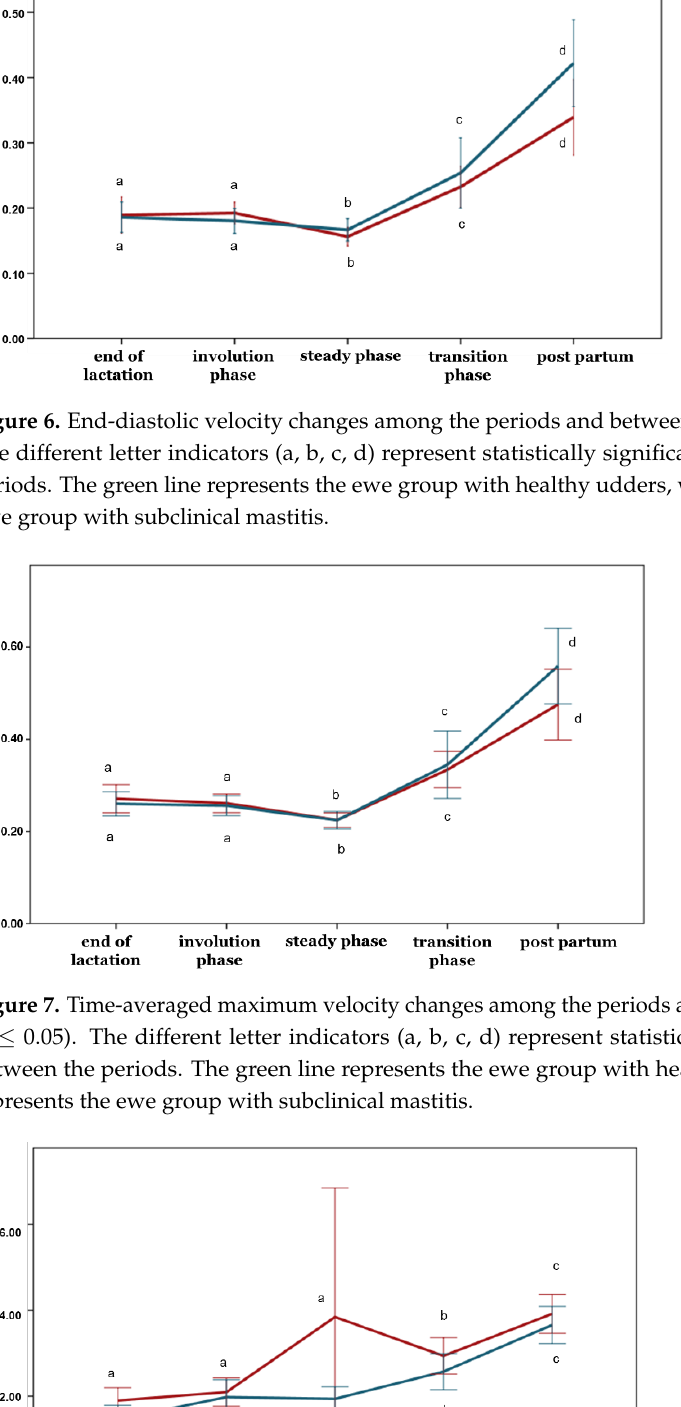
Figure 5. Resistive index changes among the periods and between the ewe groups ( p ≤ 0 .05). The different letter indicators (a, b, c) represent statistically significant differences between the periods. The green line represents the ewe group with healthy udders, while the red represents the ewe group with subclinical mastitis.